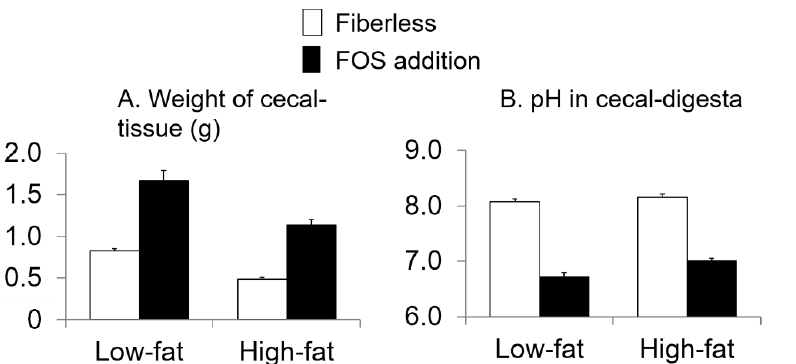
Figure 4. Effects of fat intake and fructo-oligosaccharide (FOS) supplementation on the weight of cecal-tissue ( A ) and pH in cecal-digesta ( B ). Values are Means ± SEM. n = 8 per group. two-way ANOVA.